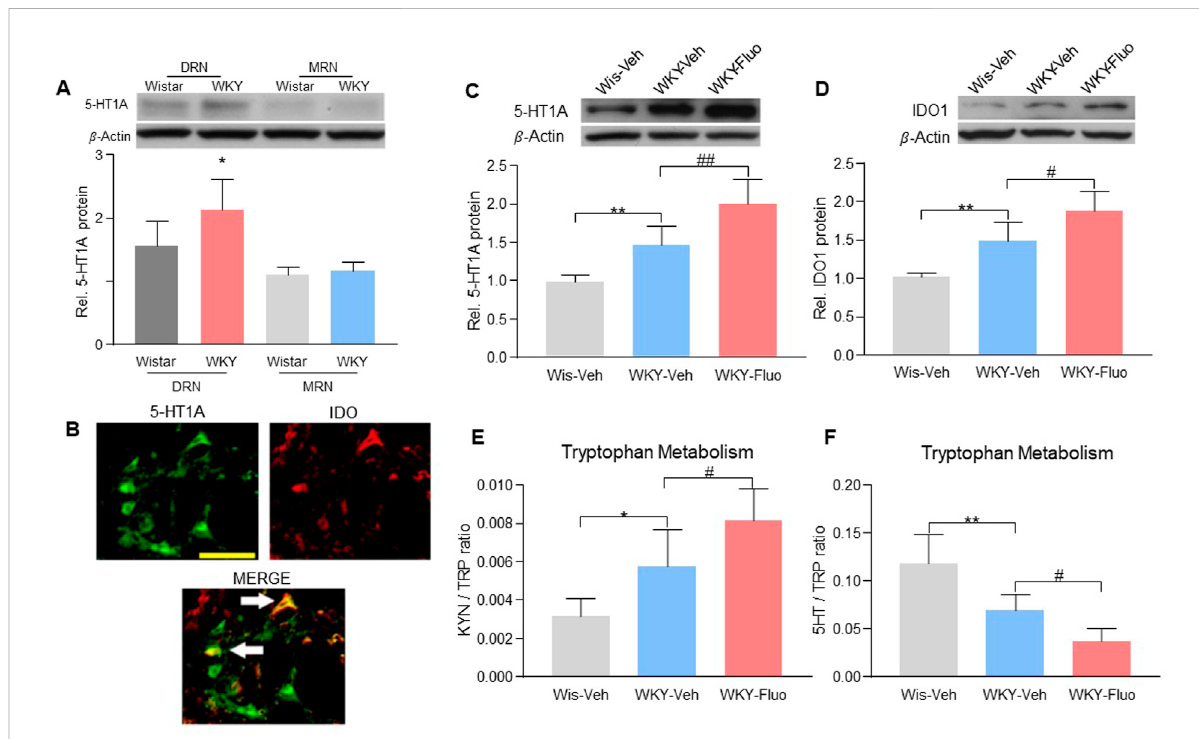
FIGURE 2 Fluoxetine maintenance treatment increased the expression of 5-HT1A auto-receptors and IDO1 in WKY rats. (A) Band of western blot and quantitative analysis showedthattheexpression of5-HT1Areceptorswasincreased intheDRNofWKYratscompared toWistarrats. Andtherewere nodifferencesinthe5-HT1AreceptorexpressionintheMRNbetweenWistarandWKYrats. β -Actinwasincludedasacontrol.* p < 0.05comparedto the Wistar-DRN group. (B) Immuno fl uorescence staining showed the colocalization of 5-HT1A receptors and IDO1 in the DRN of WKY rats (scalebar=100 μ m).Thearrowsindicatedthemergeofthe5-HT1AreceptorsandIDO1.Proteinexpressionof5-HT1Areceptors (C) andIDO1 (D) ,as well as IDO1 activity [KYN/TRP ratio (E) , HPLC) and 5-HT/TRP ratio (F) , HPLC)] were elevated in DRN of WKY rats compared to Wistar rats (WKY-Veh vs.Wis-Veh),andwerefurtherincreasedwhentreatedwith fl uoxetine(WKY-Vehvs.WKY-Fluo).Thedataareexpressedasthemean±SD( n =6).* p < 0.05 and ** p < 0.01, Wis-Veh vs. WKY-Veh; # p < 0.05 and ## p < 0.01, WKY-Veh vs. WKY-Fluo. DRN, Dorsal Raphe Nucleus; MRN, Magnus Raphe Nucleus Rel. Indicates relative; Wis, Wistar; Veh, vehicle; Fluo, fl uoxetine; KYN, kynurenine; TRP,